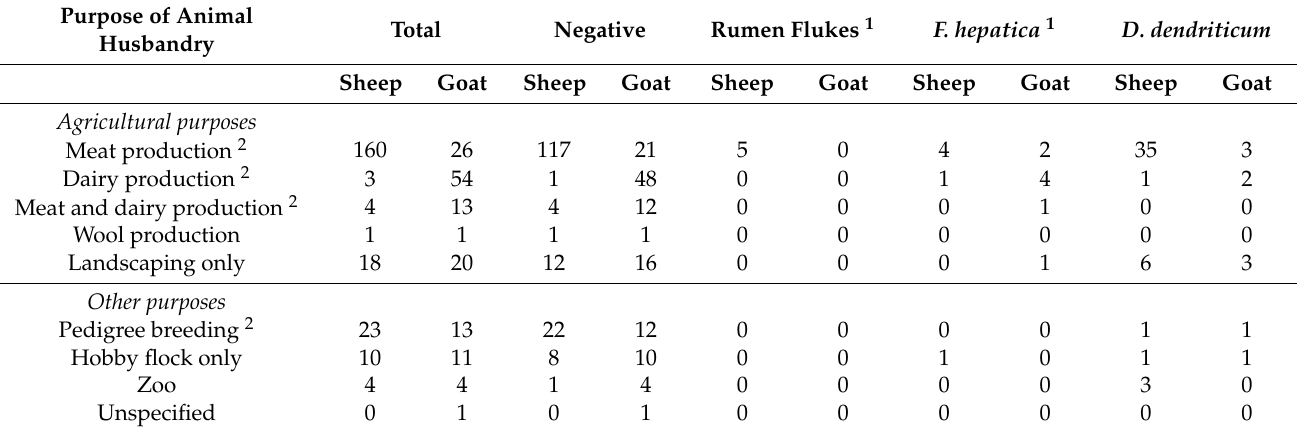
Table 4. Patent rumen and liver fluke infections on Bavarian and Lower Saxonian sheep ( n = 223) and goat farms ( n = 143) in relation to the purpose of animal